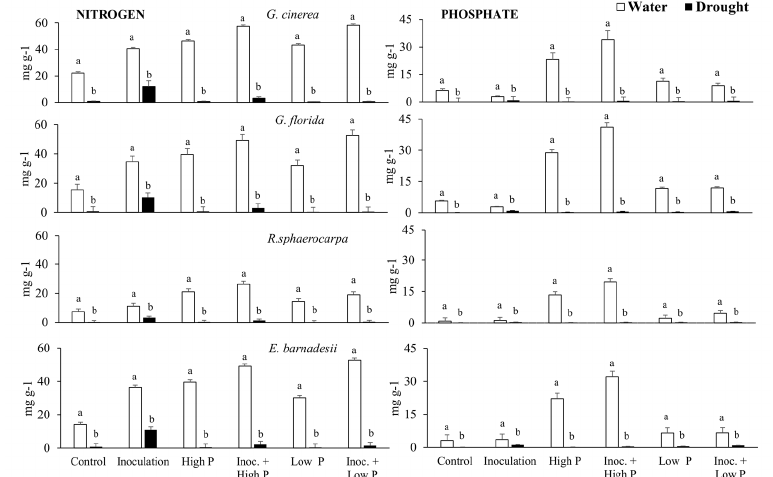
9 of 16 Figure 4. Number of nodules per plant of G. cinerea , G. florida , E. barnadesii and R. sphaerocarpa grown inoculated and inoculated plus high (500 µM) or low (5 µM) Phosphorus, under two water regimes (water: well irrigated; drought: water stress). Values are presented as means ( n = 13–15) with standard error bars and letters indicating significance. 3.4. Nitrogen and Phosphorus Efficiencies and Allocation Total P concentration in well-irrigated plants was very low in seedlings of R. sphaerocarpa . P concentration for well-irrigated plants of the four species was always significantly greater in the high